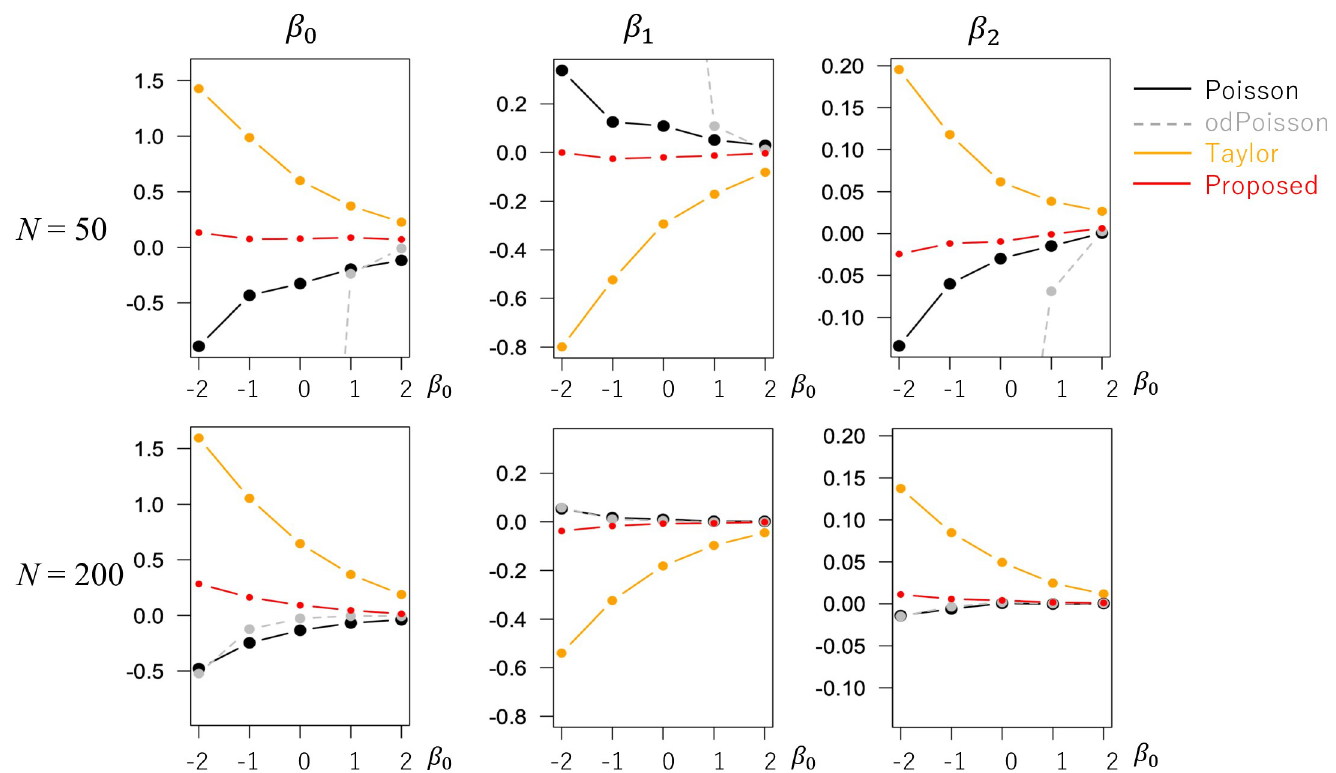
Fig 8. Bias of the regression coefficients (model with spatial effects) (x-axis: β 0 , y-axis: Bias).